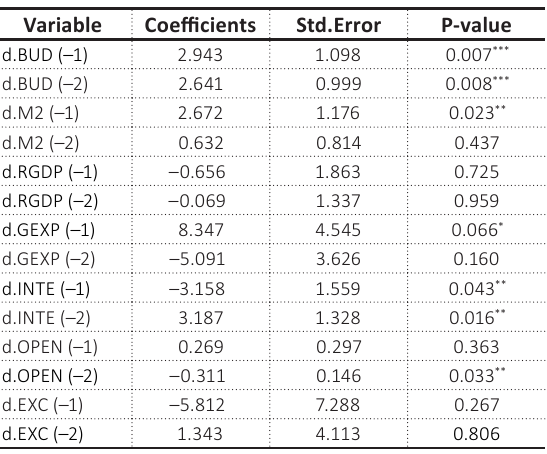
Table 3. VAR model estimation